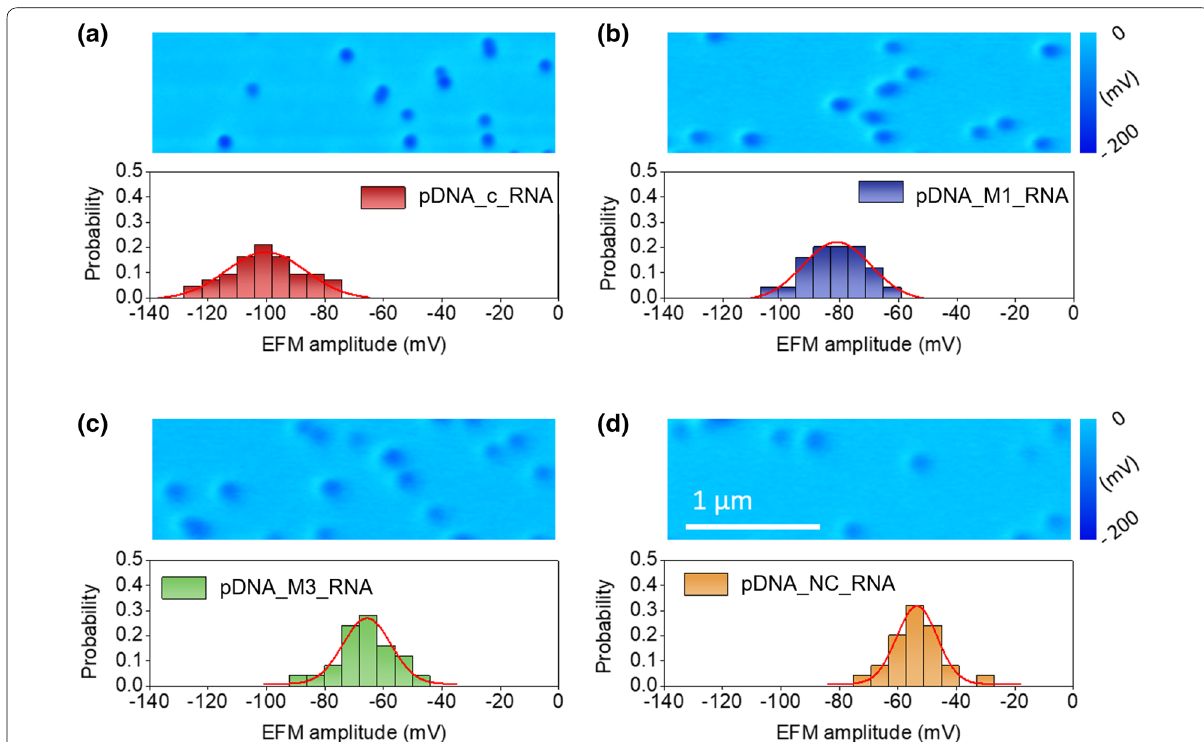
Fig. 4 a – d Electrostatic force measurements and Gaussian distribution of the DCNPs: a pDNA and d pDNA NC_RNA. To confirm whether our approach can discriminate between two neighboring conditions (i.e., pDNA + pDNA M1_RNA, pDNA M1_RNA/pDNA M3_RNA, and pDNA + + + between each group. P-values were calculated using a t-test (P <